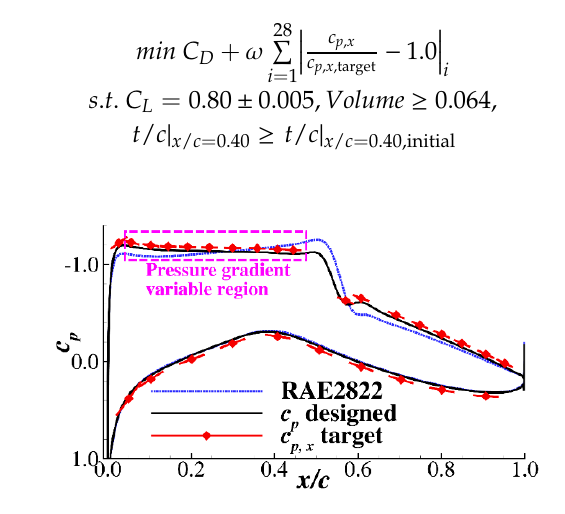
Figure 12. Pressure gradient target of supercritical airfoil.